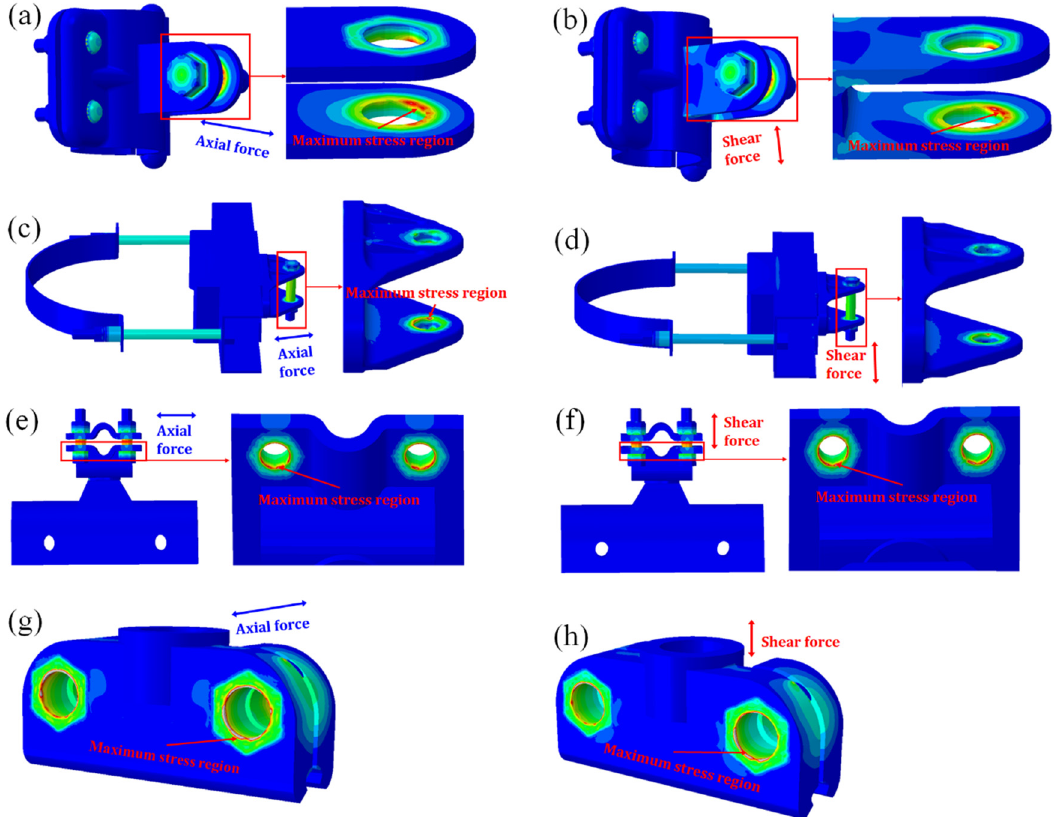
Figure 15: Stress concentration contour plot of the four connection components. ( a ) Bushing ears under axial force; ( b ) bushing ears under shear force; ( c ) support base under axial force; ( d ) support base under shear force; ( e ) messenger clamp under axial force; ( f ) messenger clamp under shear force; ( g ) contact clamp under axial force; ( h ) contact clamp under shear